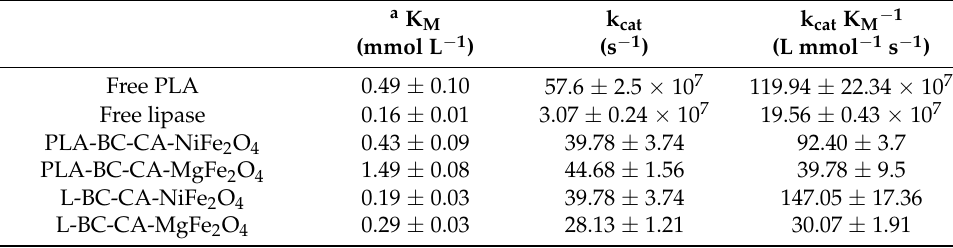
Table 3. The values of catalytic constants of immobilized enzymes on both carrier